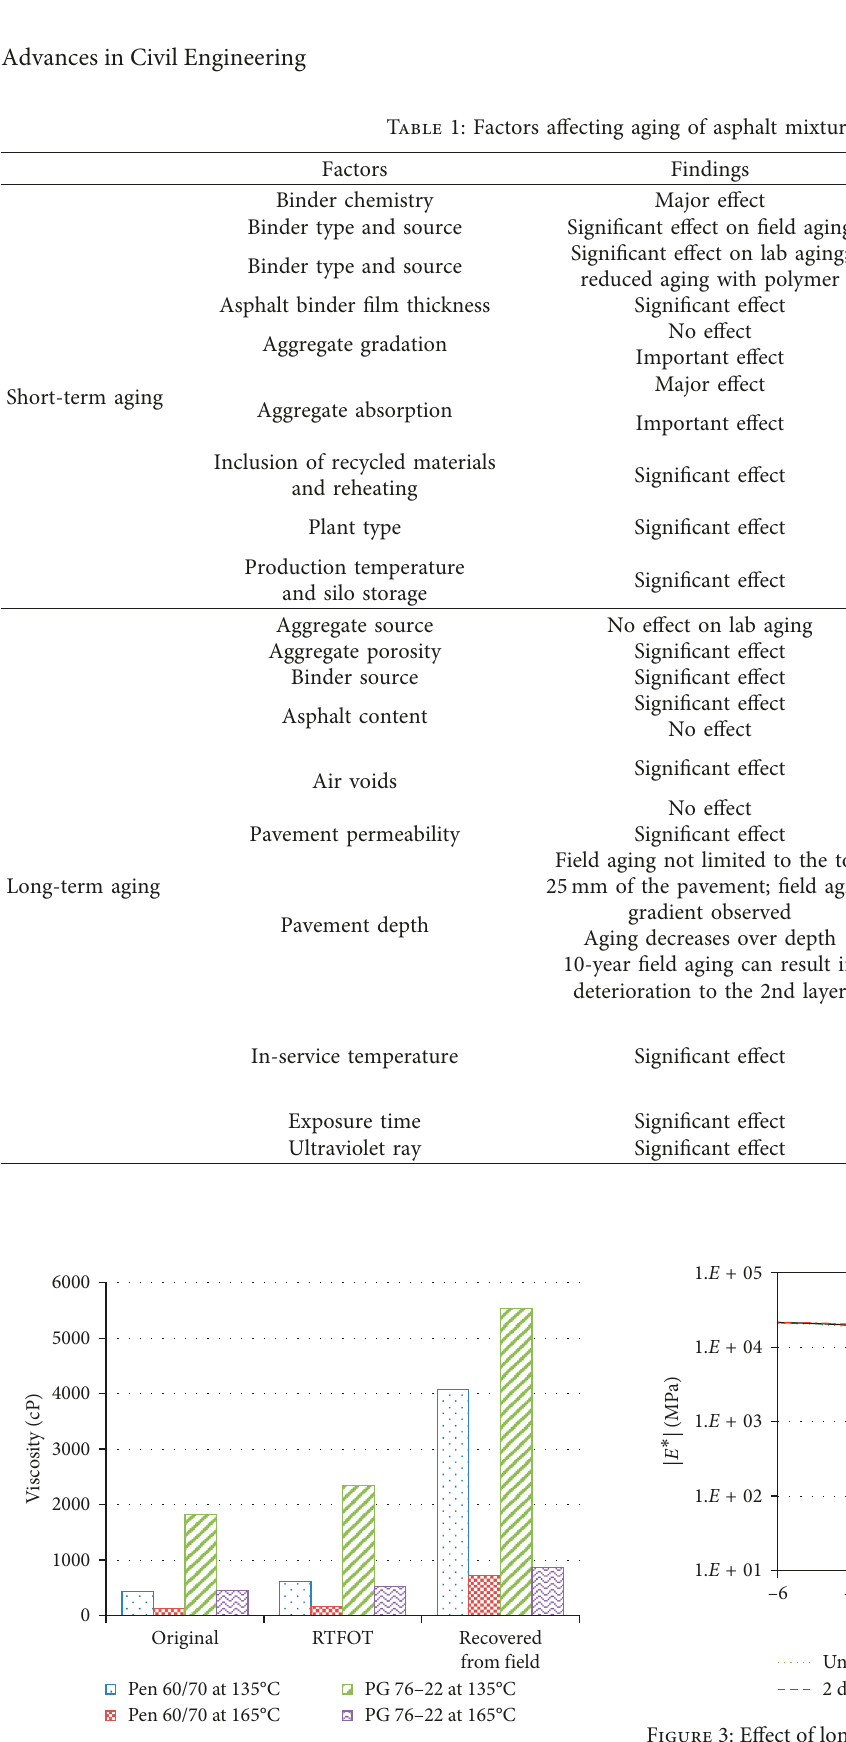
Figure 2: Effect of 5-year aging on the viscosity of asphalt binders.